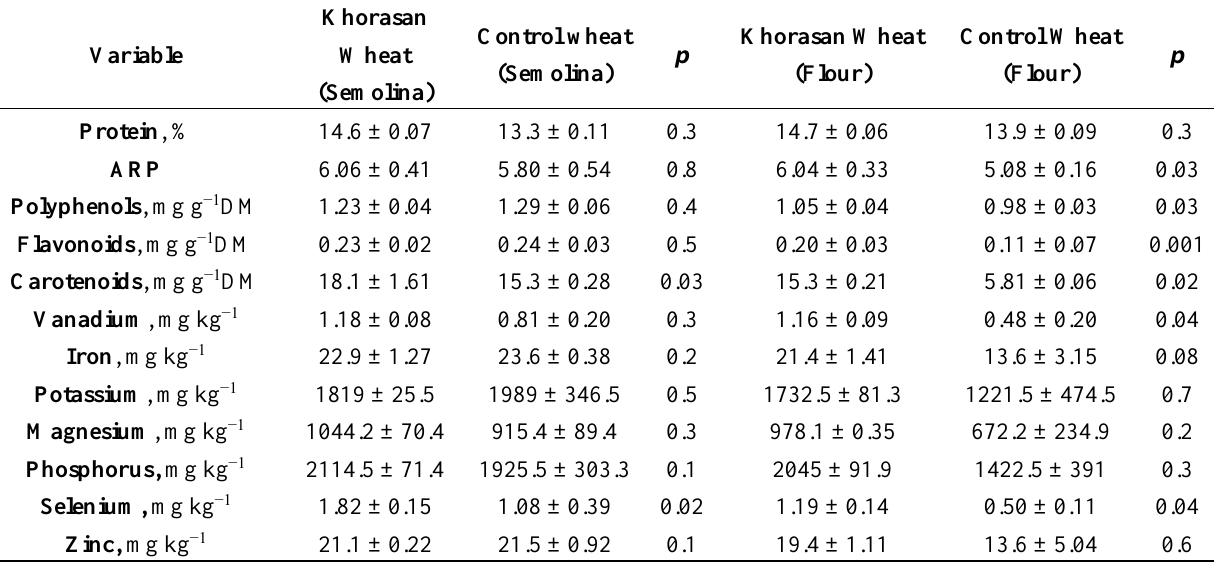
Table 1. Composition of khorasan wheat and control